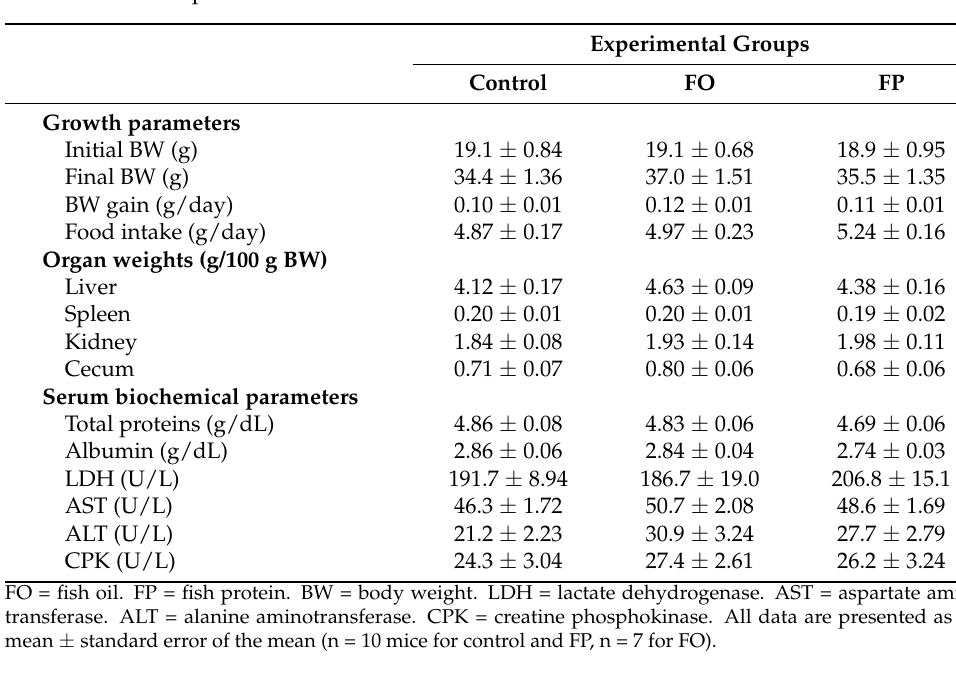
Table 4. Growth parameters, relative organ weights, and serum biochemical parameters of 6-month- old mice fed the experimental diets for five months.